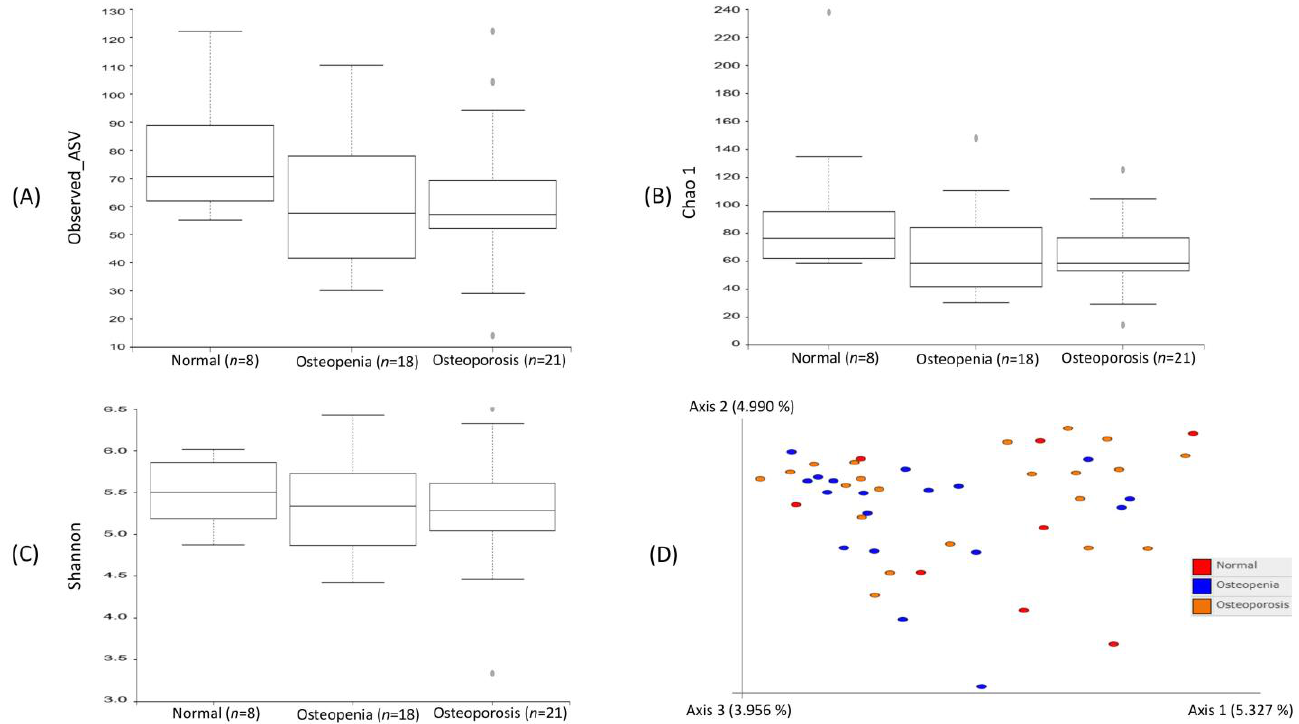
Figure 1. Comparison of bacterial community diversity among the experimental groups: normal control, osteopenia, and osteoporosis. Alpha diversity among the experimental groups was measured by Observed_ASV, Chao1, and Shannon, whereas beta diversity based on Bray–Curtis was measured using principal coordinate analysis.